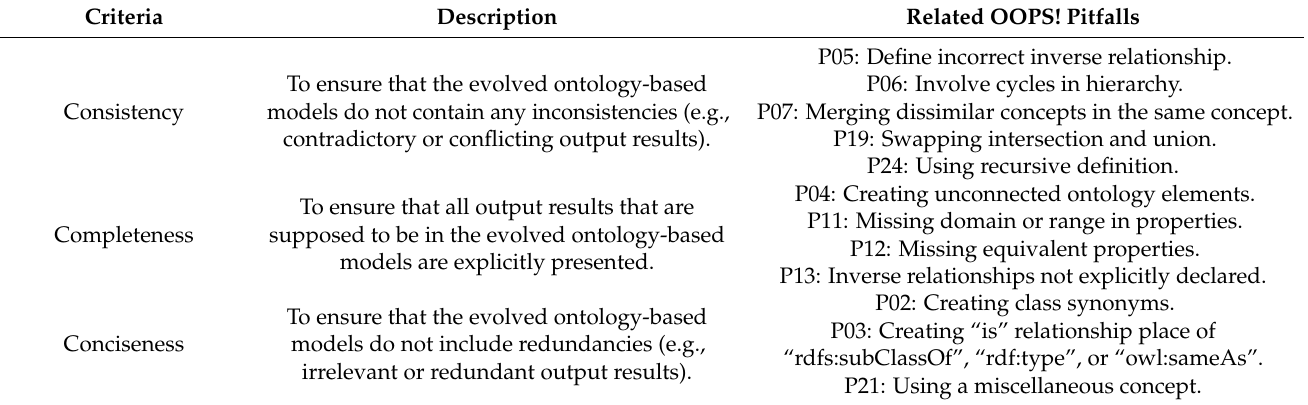
Table 6. Basic criteria for evolved ontology-based models’ content evaluation. Criteria Description Related OOPS! Pitfalls